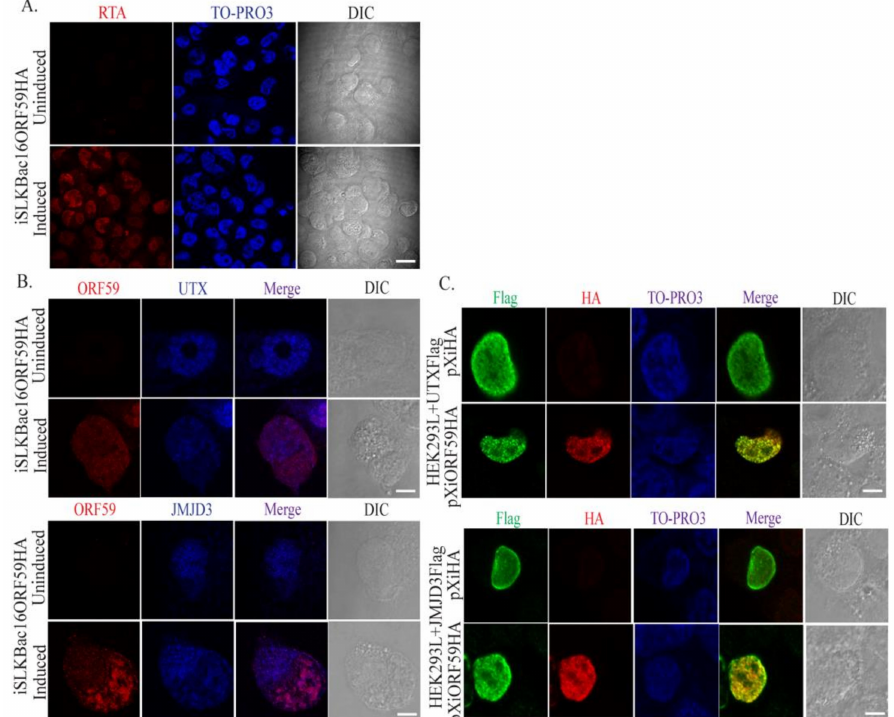
Figure 2. ORF59 co-localized with UTX and JMJD3 in the nuclear compartments. ( A ) Immunofluorescence analysis for RTA protein detection in 24 h-induced iSLK / Bac16-ORF59HA cells indicated almost all the cells underwent lytic reactivation; scale bar: 100 µ m. The 24 h-induced iSLK / Bac16-ORF59HA cells ( B ) or transfected HEK293 cells ( C ) were stained with antibodies against ORF59, JMJD3, and UTX. ORF59 and JMJD3 or UTX localized at many foci in the nucleus of the induced cells (merge signal); scale bar: 20 µ